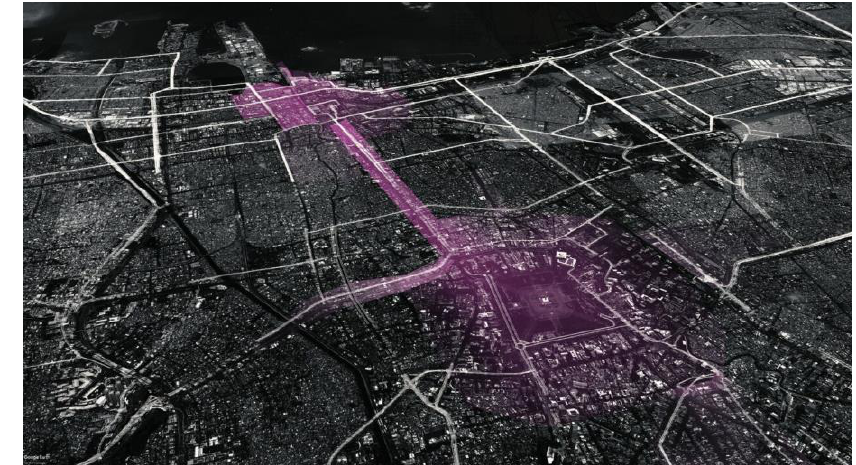
Figure 18. Study map manifesting the two city centers: Batavia-stad and Weltevreden (Developed by Author).